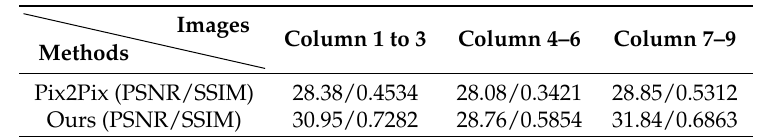
Figure 7. Some facial images in the training data. Table 4. Quantitative evaluation of Pix2pix and our work. We evaluated average PSNR/SSIM for images in Figure